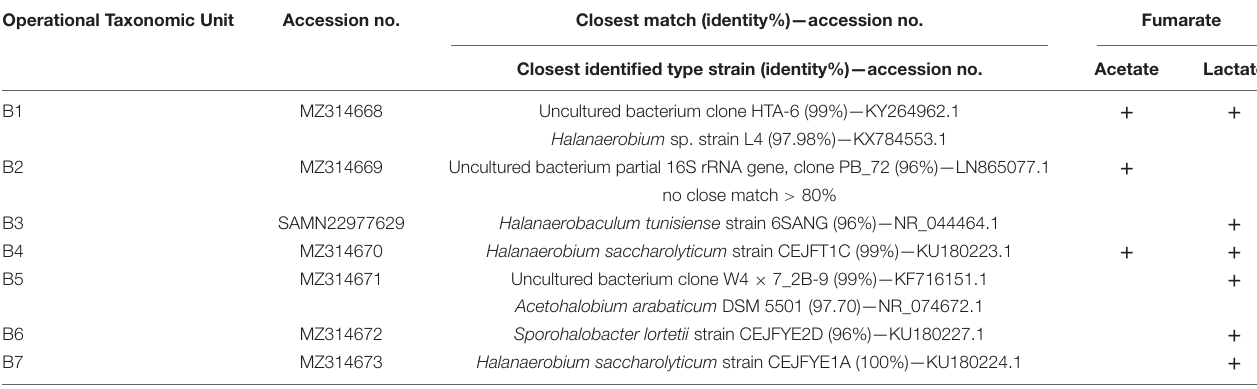
TABLE 3B | 16S rRNA gene sequences detected in cultures developed on either acetate of lactate as the electron donor and fumarate as the electron acceptor upon amplification, DGGE separation, reamplification, and sequencing of bacterial DNA. Operational Taxonomic Unit Accession no. Closest match (identity%)—accession no.